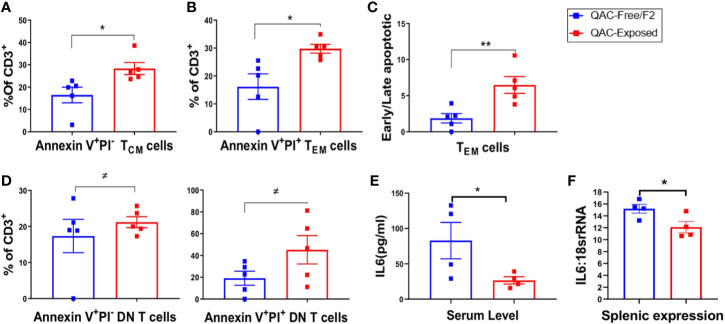
Increased apoptosis of T cells with ambient exposure to QACs. (A) Percentage of early apoptotic TCM cells gated as AnnexinV+PI− on CD3+CD62L+CD44+ cells. (B) Percentage of late apoptotic or necrotic TEM cells gated as AnnexinV+PI+ on CD3+CD62L-CD44+ cells. (C) Ratio of early apoptotic (AnnexinV+PI−) to late apoptotic or necrotic (AnnexinV+PI+) TEM cells. (D) Percentage of early and late apoptotic DN-T cell as the percentage of CD3+ T lymphocytes. (E) Serum level of IL-6. (F) Transcript level of IL-6 in whole spleen. Data from the 1st experimental setting are shown as mean ± SEM. ≠P < 0.10, *P < 0.05, **P < 0.01.